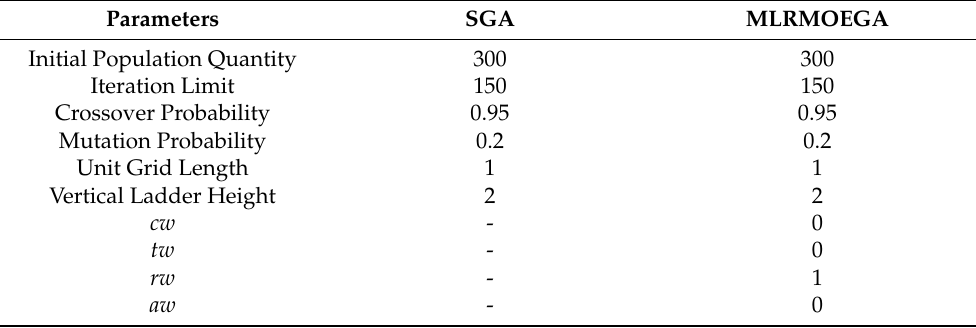
Table 2. Parameters of SGA and MLRMOEGA.